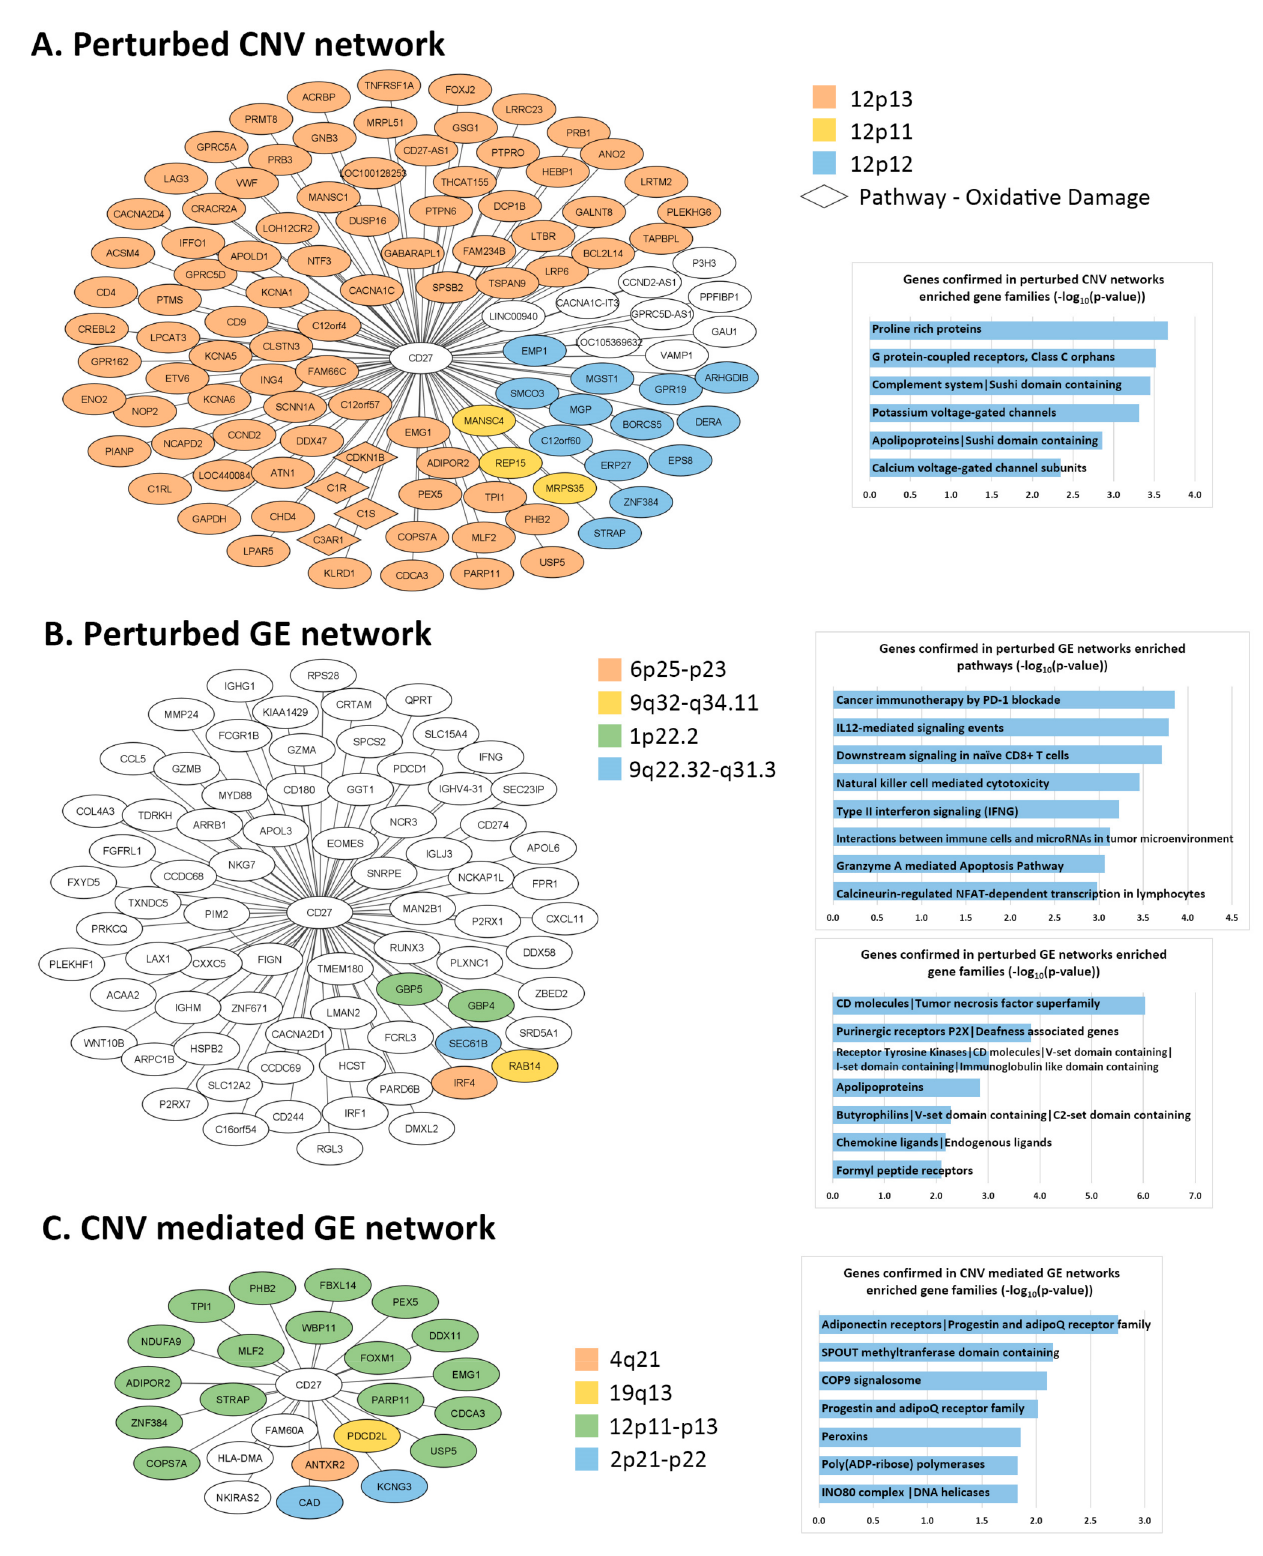
Figure 2. CD27 multi-omics networks in NSCLC. ( A ) Perturbed CD27 CNV network. The plot on the left shows the genes which had a significant ( p < 0.05, z- tests) concordant co-occurrence of DNA copy number aberration with CD27 in both patient cohorts GSE31800 and GSE28582. The bar chart on the right shows the –log 10 ( p -values) of the significantly ( p <